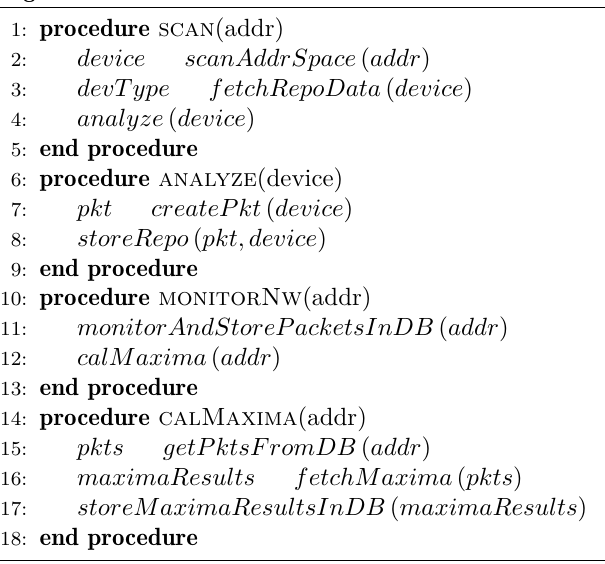
Algorithm 1 OWL Orchestration